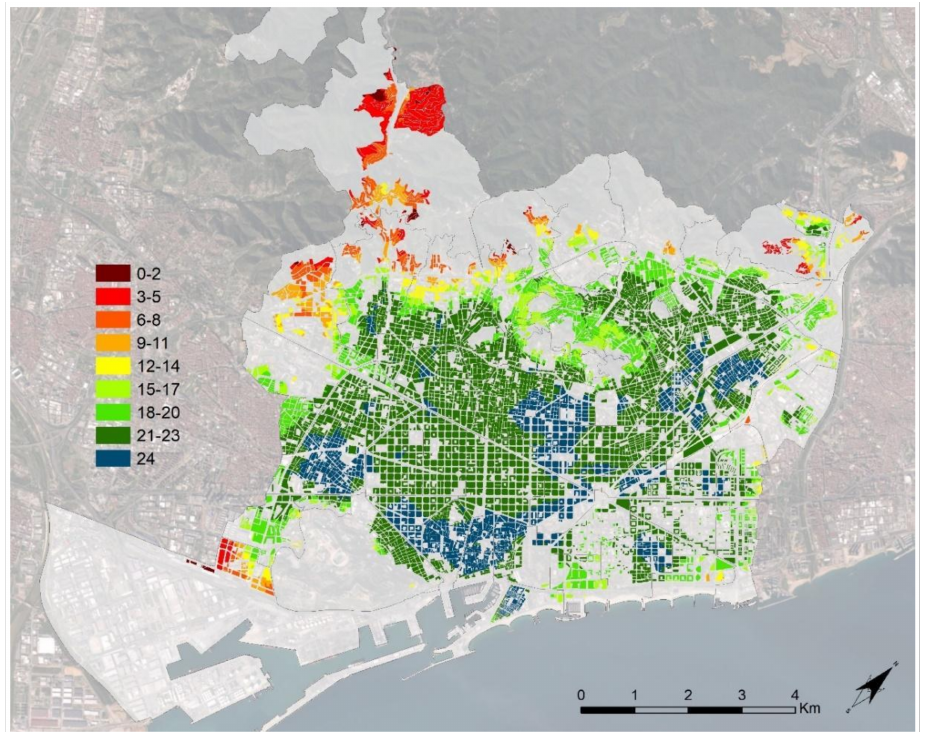
Figure 3. Synthetic Map of the 15-Minute City in Barcelona. Source: Own elaboration based on data from Open Data BCN [42], the Urban Map of Catalonia (MUC) [48] and the 1: 5000 Orthophoto from ICGC, used under a CC BY 4.0 license [41].